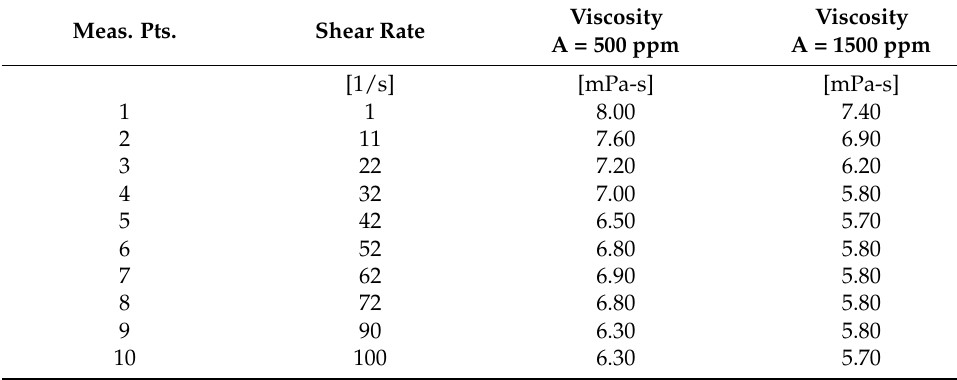
Table 10. Viscosity of the emulsion at alkali, 500 ppm, 1500 ppm, surfactant 600 ppm, polymer 600 ppm. Meas.